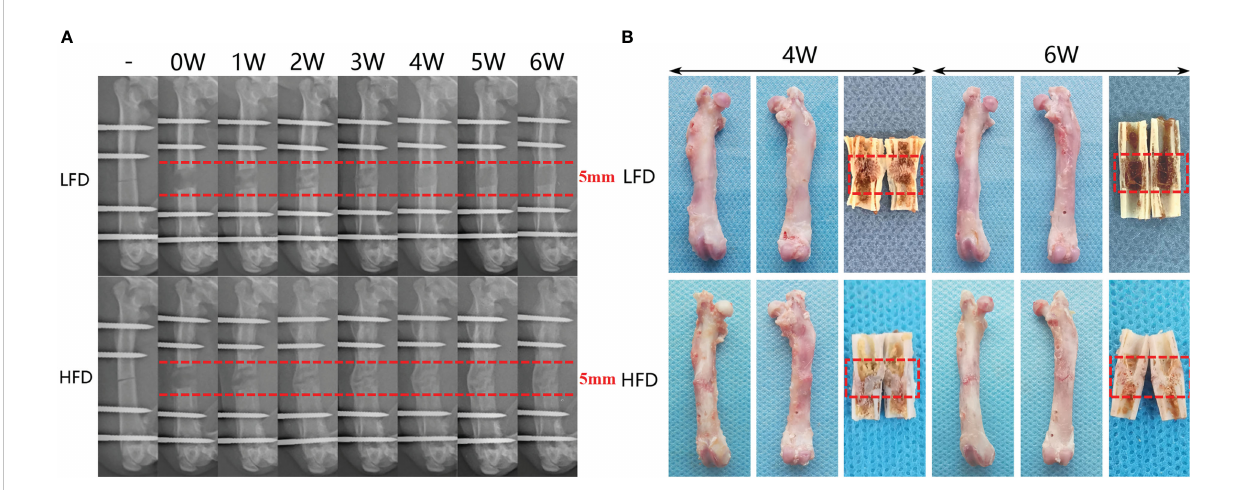
FIGURE 3 Distraction osteogenesis effects bone regeneration differently based on diet. (A) There is a six-week consolidation duration for the distraction X-ray images that regenerate each week. (B) After four- and six-week consolidation, a general image of the specimens can be